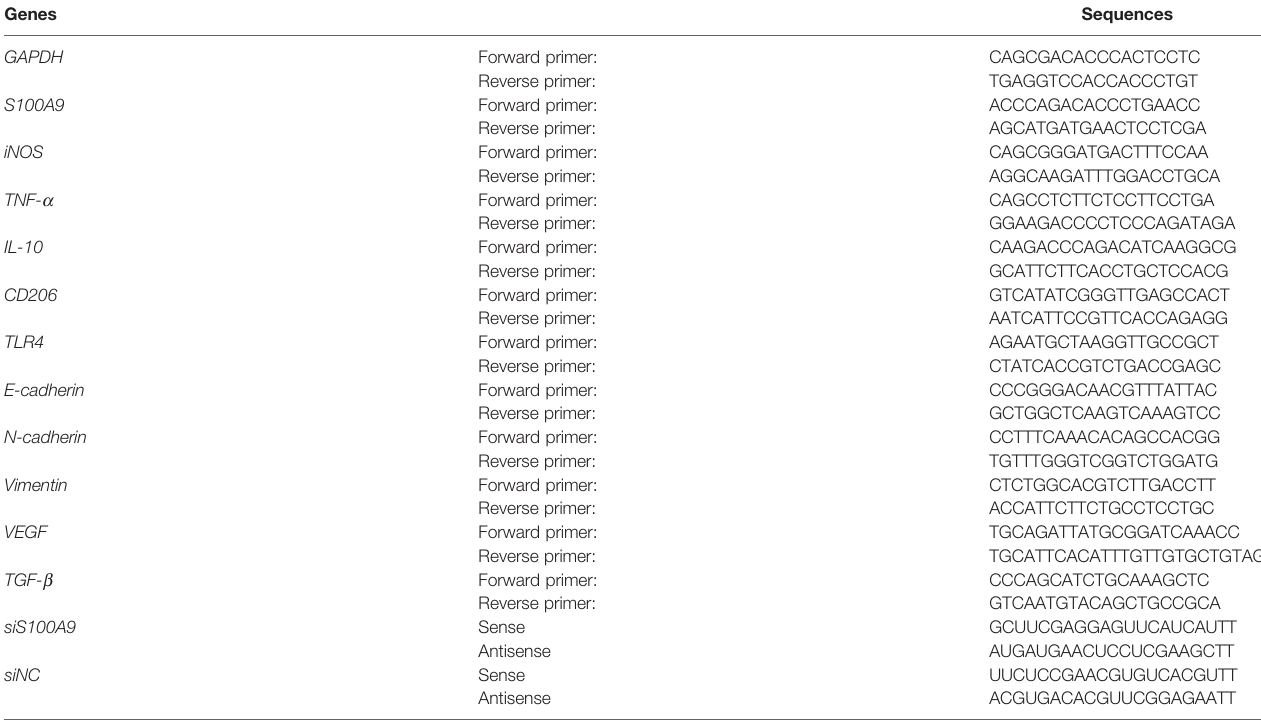
TABLE 1 | The primers and siRNA used in this